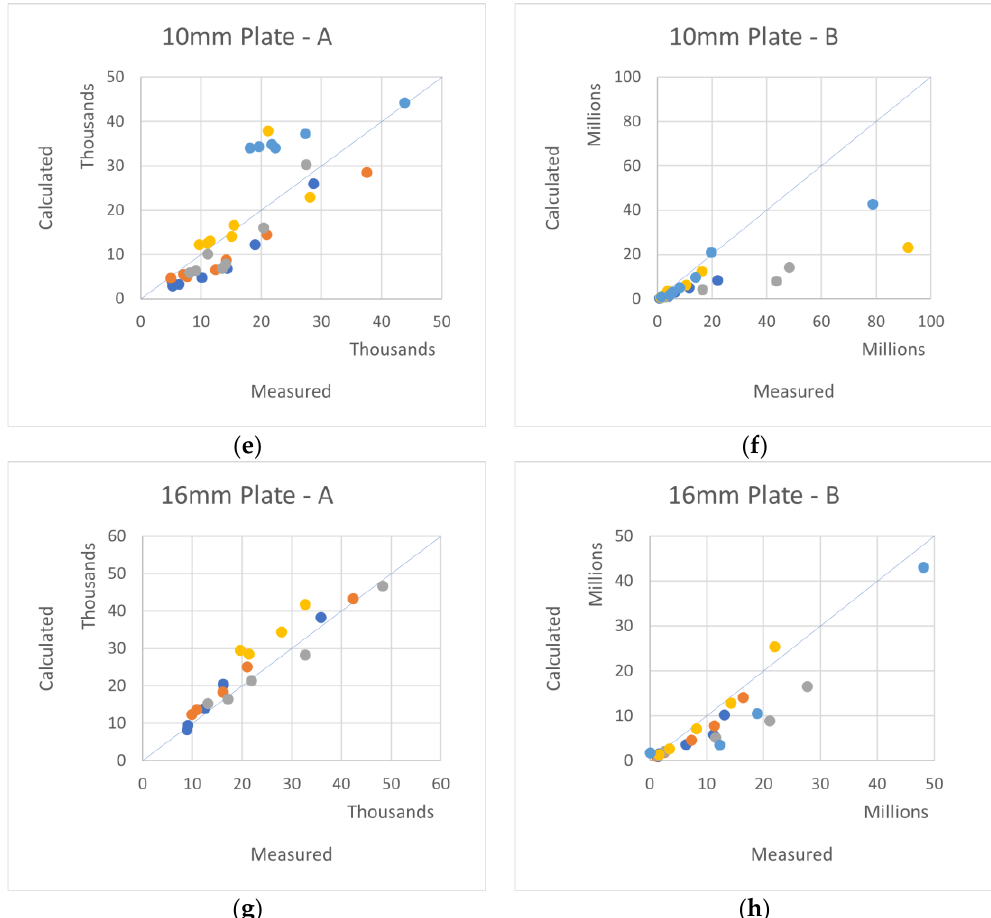
Figure 7. Measured – Calculated A , B constants — a comparison of various plates. ( a ) 6 mm A, ( b ) 6 mm B with legend, ( c ) 8 mm A, ( d ) 8 mm B, ( e ) 10 mm A, ( f ) 10 mm B, ( g ) 16 mm A, ( h ) 16 mm B.